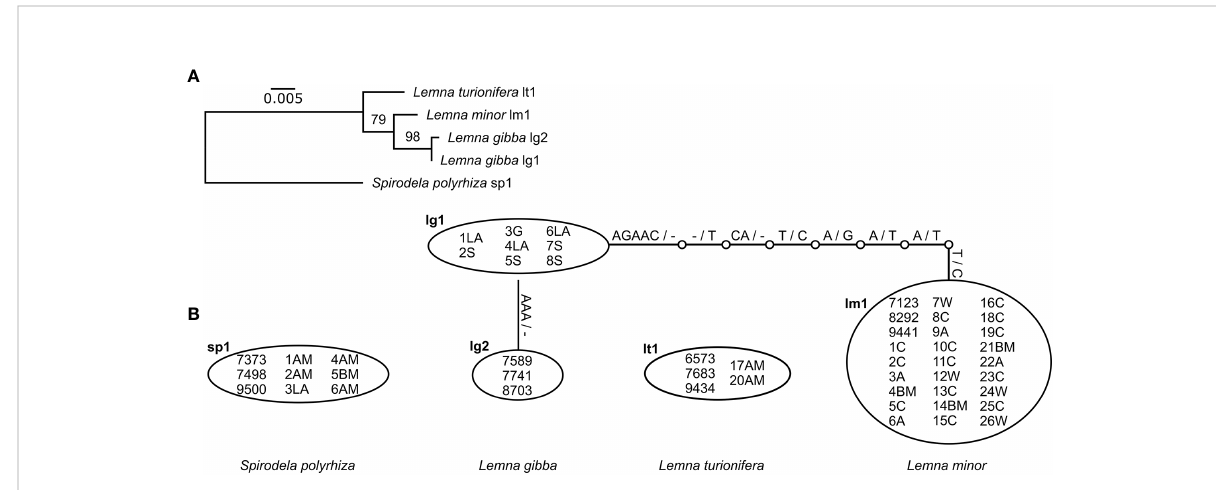
FIGURE 3 Molecular genetic results of the cp marker atpF-atpH . (A) Maximum-likelihood tree of unique haplotypes found for all investigated clones. Bootstrap values based on 1,000 replicates. Spirodela polyrhiza was set as outgroup. Scale indicates number of substitutions per site. (B) Identi fi cation of haplotypes and their differences for all investigated clones. Substitutions are given on the lines. - denotes